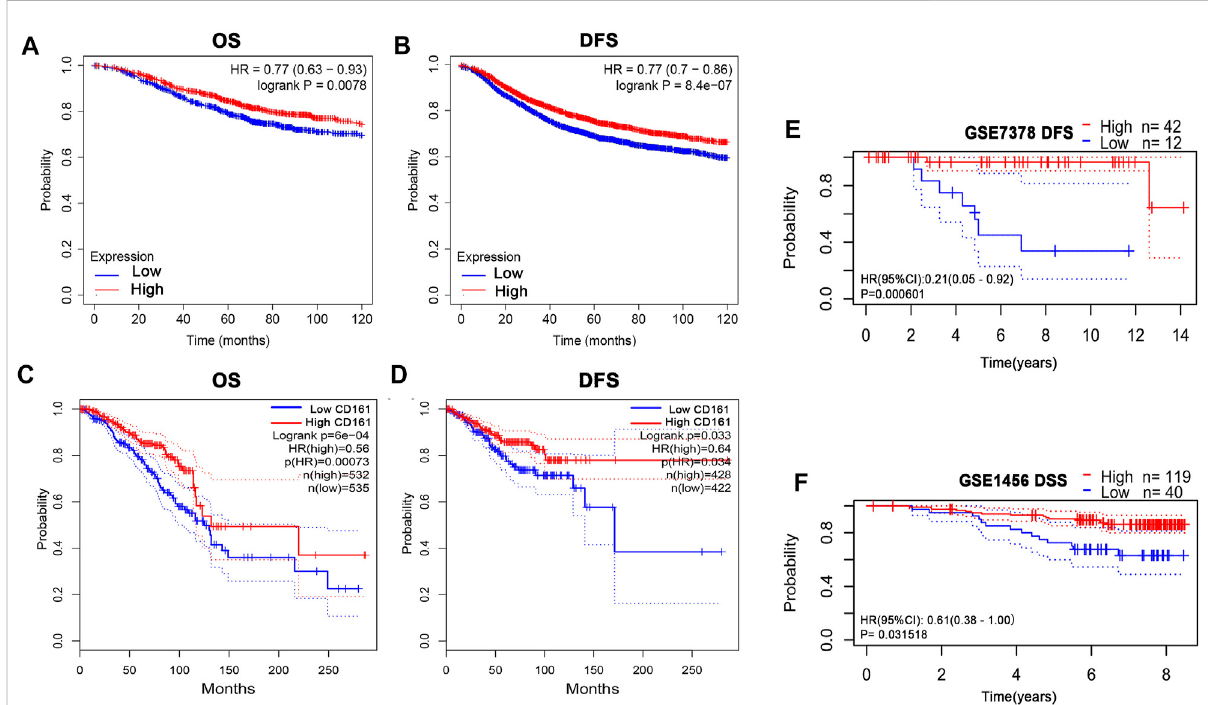
FIGURE 2 Kaplan-Meier assessment for survival outcomes according to CD161 expression in BC patients. (A) The OS estimate of high CD161 expression survivors was higher than low CD161 expression survivors from Kaplan – Meier Plotter database ( p < 0.01). (B) The DFS estimate of high CD161 expression survivors was higher than low CD161 expression survivors from Kaplan – Meier Plotter database ( p < 0.001). (C) The OS estimate of high CD161 expression survivors was higher than low CD161 expression survivors from GEPIA database ( p < 0.001). (D) The DFS estimate of high CD161 expressionsurvivorswashigherthanlow CD161 expressionsurvivorsfromGEPIAdatabase( p =0.03). (E) High CD161 expressionsurvivorshad improved DFS compared with low CD161 expression survivors in GSE7378 from PrognoScan database ( p < 0.001). (F) High CD161 expression